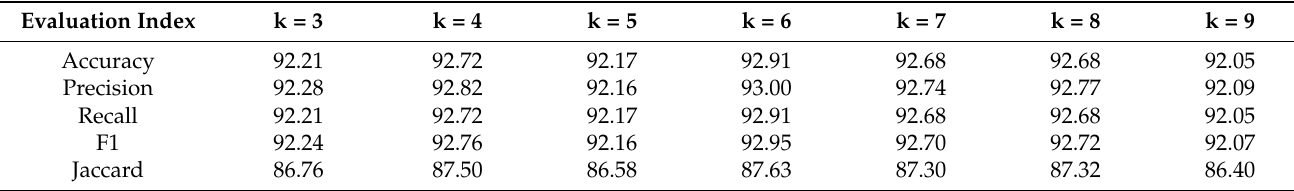
Table 3. Selection of parameter k.